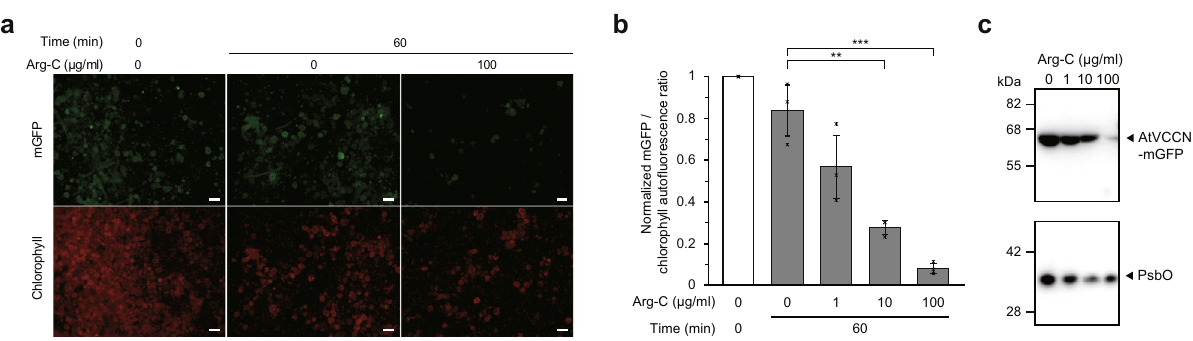
Fig. 2 Topology evaluation of VCCN1 in chloroplasts. a Representative images of mGFP digestion by Arg-C on isolated chloroplasts with transient expression of AtVCCN1-mGFP. The scale bar represents 50 µ m. b Quenching level of GFP fl uorescence with or without Arg-C treatment for 60 min. GFP signals were detected with a fl uorescent microscope. The GFP signal was normalized with the chlorophyll auto fl uorescence signal. Error bars represent mean ± S.D. from independent experiments ( n = 3). ** P < 0.01, *** P < 0.001, two-sided student ’ s t test. Exact P values are as follows, ** P = 0.00329, *** P = 0.00099. Source data are provided as a Source Data fi le. c Western blotting analyses of AtVCCN1-mGFP and PsbO, with or without Arg-C treatment. AtVCCN1-mGFP and PsbO were immunoblotted by an anti-GFP antibody and an anti-PsbO antibody, respectively. The experiment was repeated three times independently, with